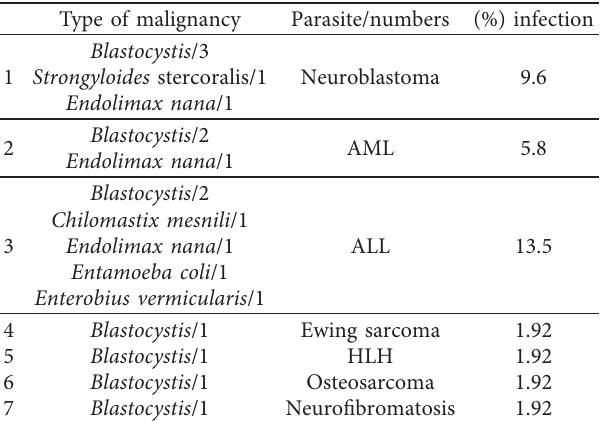
Table 3: The frequency of intestinal parasites and the type of malignancy in children with